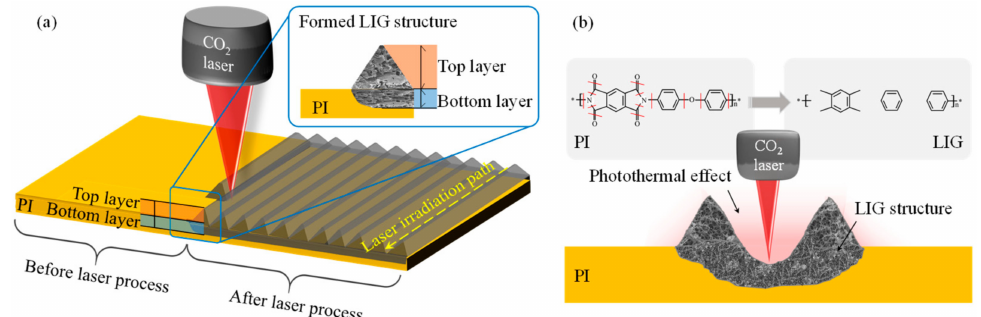
Figure 2. Schematic of ( a ) LIG fabrication by laser irradiation and ( b ) reaction principle of laser irradiation